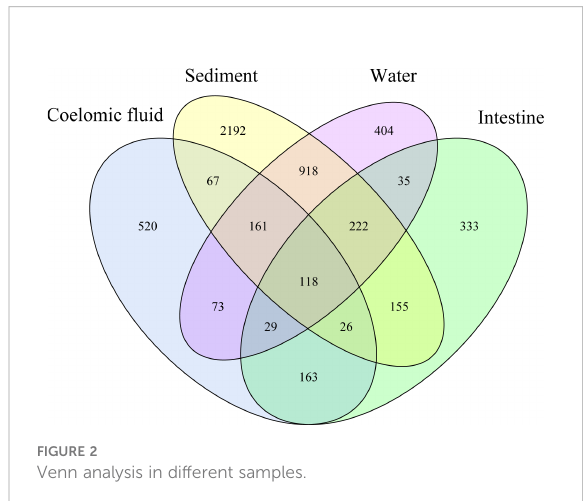
FIGURE 2 Venn analysis in different